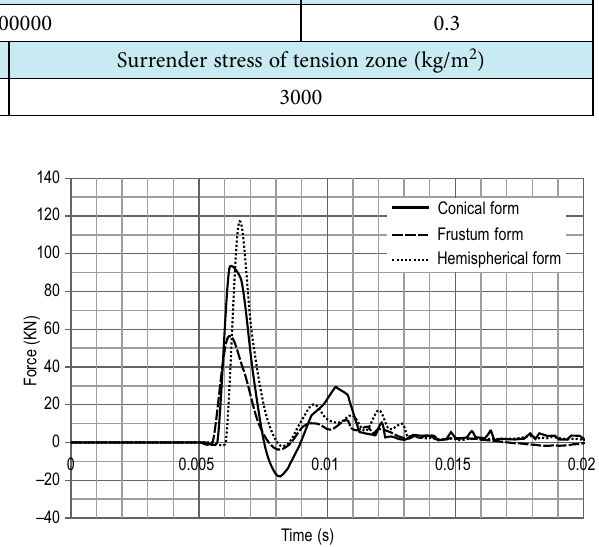
Table 2. Properties of materials used in Finite Element models Density (kg/m 3 )